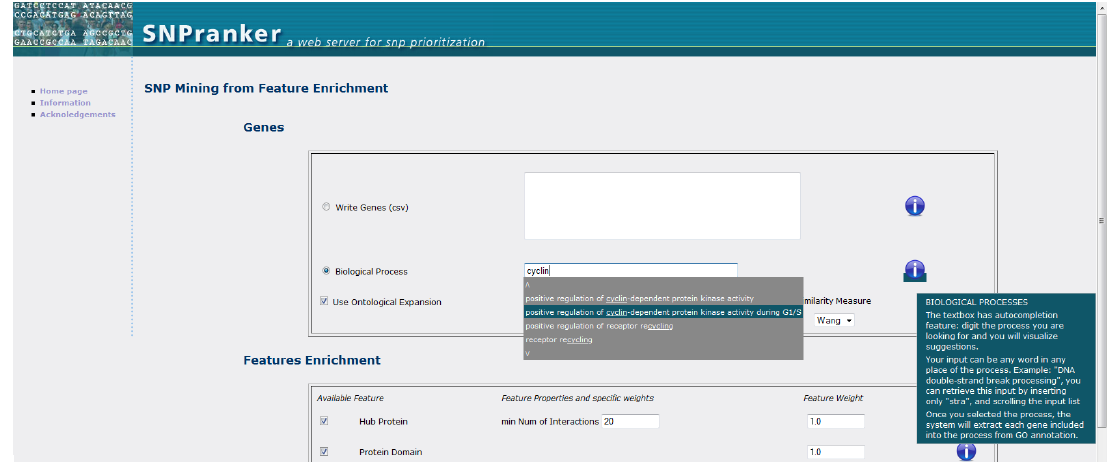
Figure 2: Screenshot from the web site. Input gene list definition.